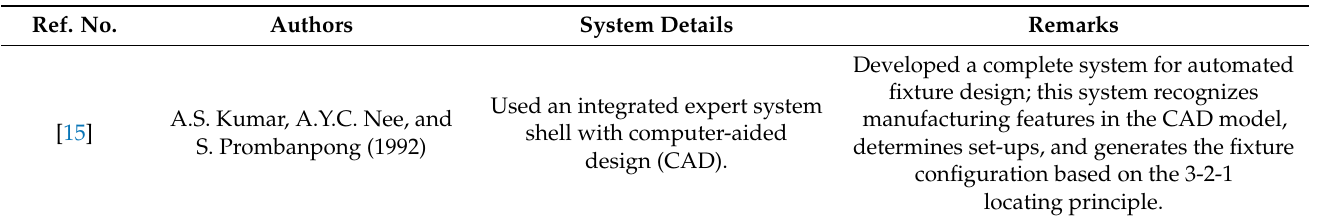
Table 1. Summary of major research work on computer-aided design of jigs and fixtures. Ref.